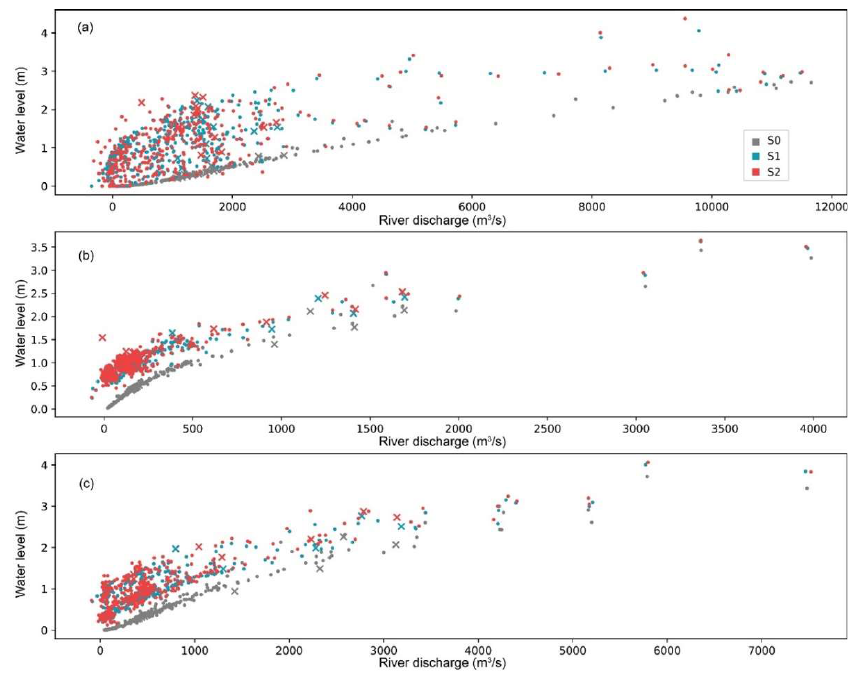
Figure 10. The rating curve (discharge–stage relation) for daily time scale at three river channels. Those marked as points are normal periods, but those marked with a cross occurred during the Lekima typhoon period. ( a – c ) show the results at three locations: p0, p1, and p2.